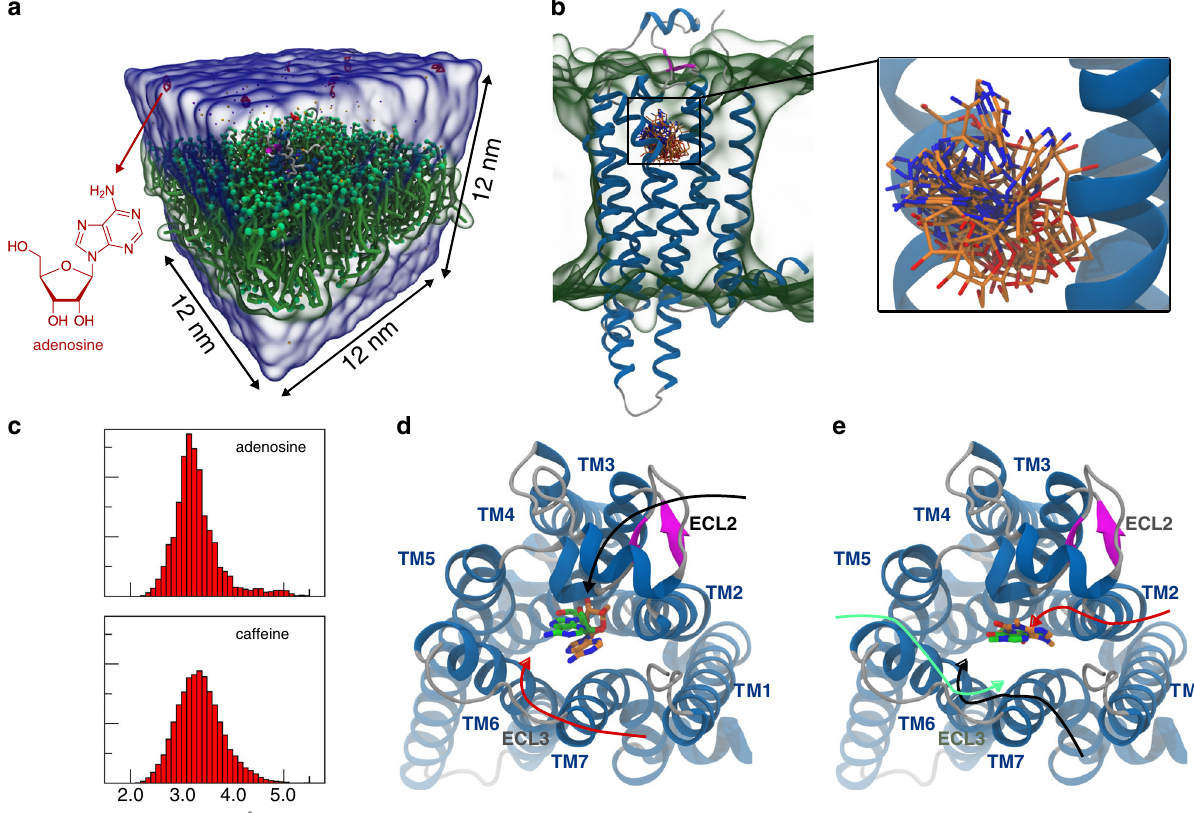
Fig. 2 Unbiased simulations of adenosine/caffeine binding to A 2A R at the CG Martini level. a Simulation box containing the A 2A R embedded in a POPC bilayer (green) and eight adenosine molecules (red) solvated in water (transparent blue surface). b Multiple binding poses of adenosine obtained from the CG model by back-mapping 50 . Only structures with an RMSD below 2.6 Å with respect to the crystallographic ligand-binding mode are shown. The structure of A 2A R is reconstructed based on the crystal structure (PDB code: 3RFM). The back-mapped ligands are shown in licorice with carbon atoms depicted in orange, nitrogen atoms in blue, and oxygens in red. c Histograms of the RMSD of all the binding poses of adenosine (top) and caffeine (bottom) observed during the simulations. d , e Comparison of the crystallographic binding mode of adenosine ( d )/caffeine ( e ) (green) and the best binding pose obtained from CG MD simulations (orange) with the most recurring binding paths (black, red, and green